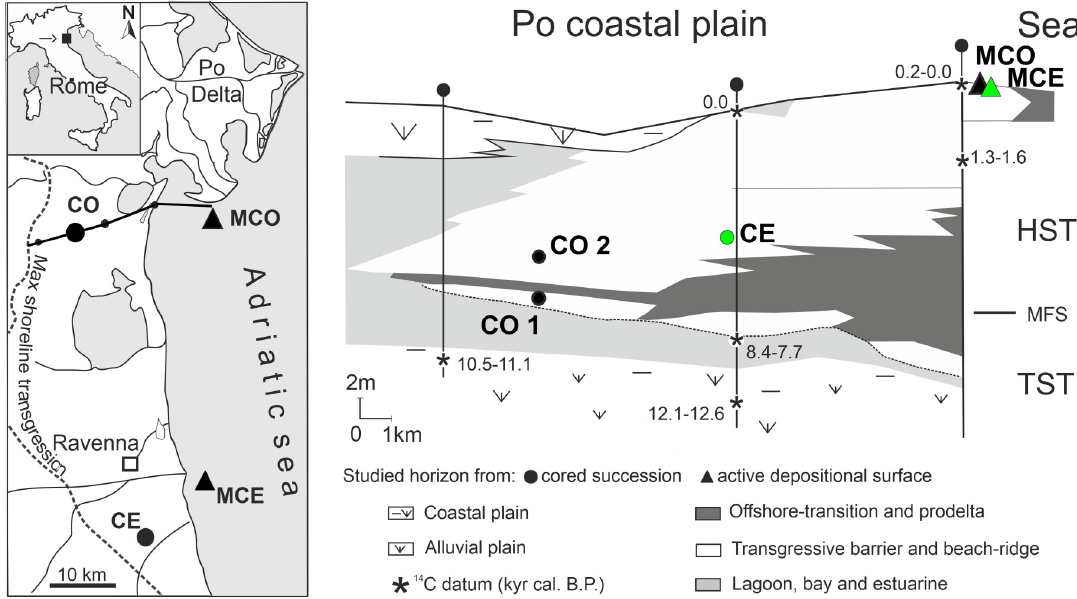
Fig 1. Study area map and stratigraphic framework of the latest Quaternary Po coastal plain-sedimentary succession (reprinted slightly modified from Scarponi et al . [31], under a CC BY license, with permission from the geological society of America original copyright 2013). In the left panel, black dots mark the locations of sampled cores (CO, CE), black triangles mark sampled thanatocoenosis from present-day shoreface environments (MCE, MCO), and the black solid line represents the along-dip cross section of the Po coastal plain (right panel). Right panel shows sketched climate driven environmental changes within the study area during the Holocene, see also Fig 5; the dashed line indicates the wave ravinement surface (see also S1 Text in S1 File) and green-filled symbols represent projected samples on the cross-section. Acronyms: MFS = maximum flooding surface; TST = transgressive systems tract; HST = highstand systems tract.